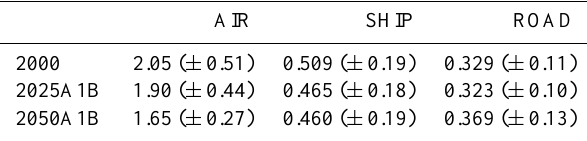
Table 2. Global annual average of the change in O 3 molecules per NO x molecule emitted from the different transport sectors, given as ensemble means and standard